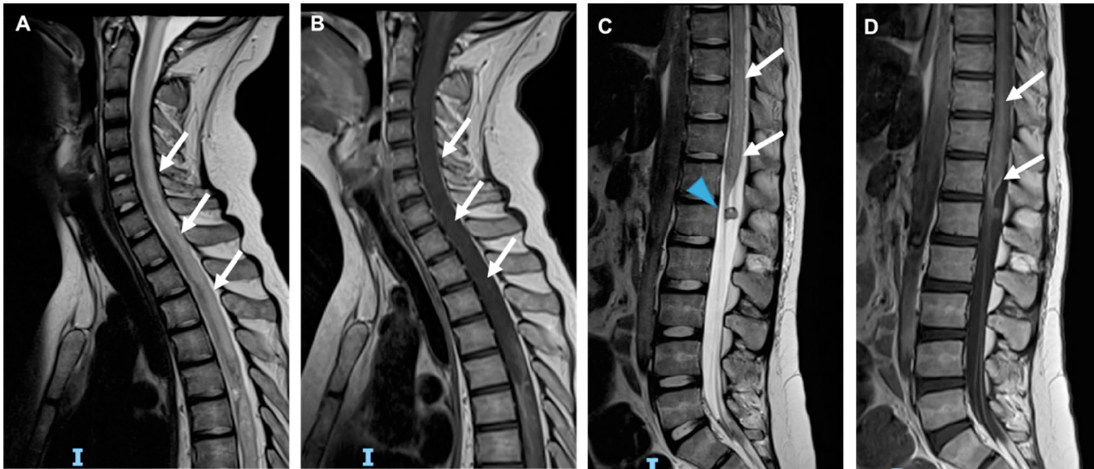
Figure 1. Acute myelitis due to chemotherapy (Nelarabina) in an ALL—T patient. Sagittal MRI shows the abnormal medullar signal of the spine (arrows, A ) without contrast enhancement after gadolinium administration (arrows, B ). C and D show an abnormal hyperintensity of the distal part of the medullar signal (arrows, C ) associated with a peripherical aspecific gadolinium enhancement (arrows, D ). A metastatic nodule was also seen (arrowhead, C ).